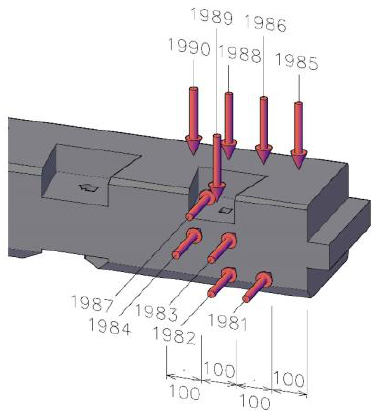
Figure 4. Marking of the points measured by Resistograph, beam (III).